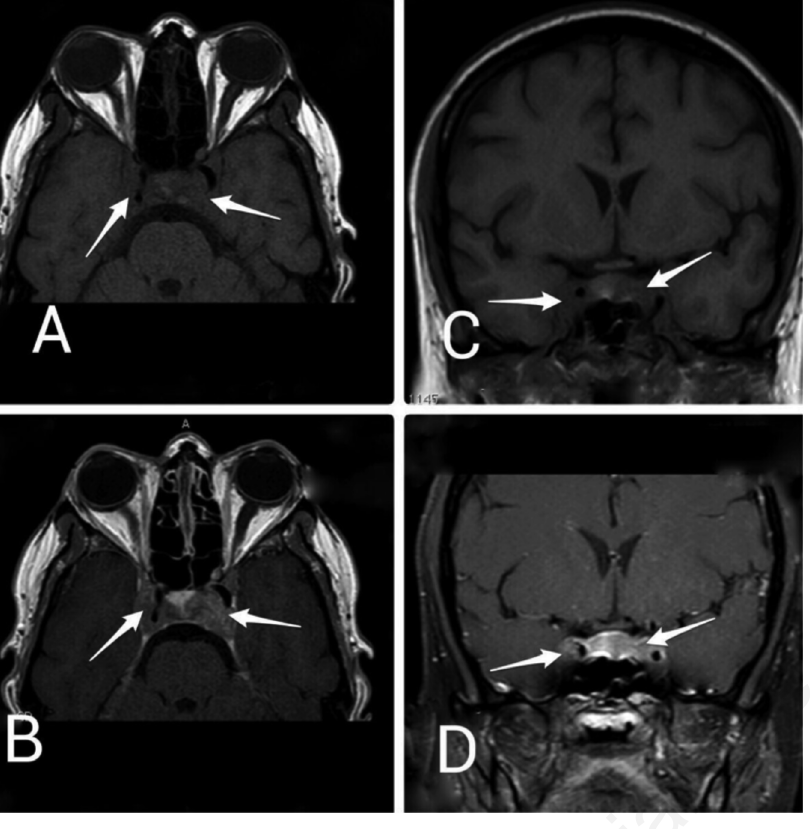
Figure 1. Axial and coronal T1 weighted images (A and C) show bilateral asymmetrical enlargement of cavernous sinuses with inhomogeneous contrast enhancement (B and